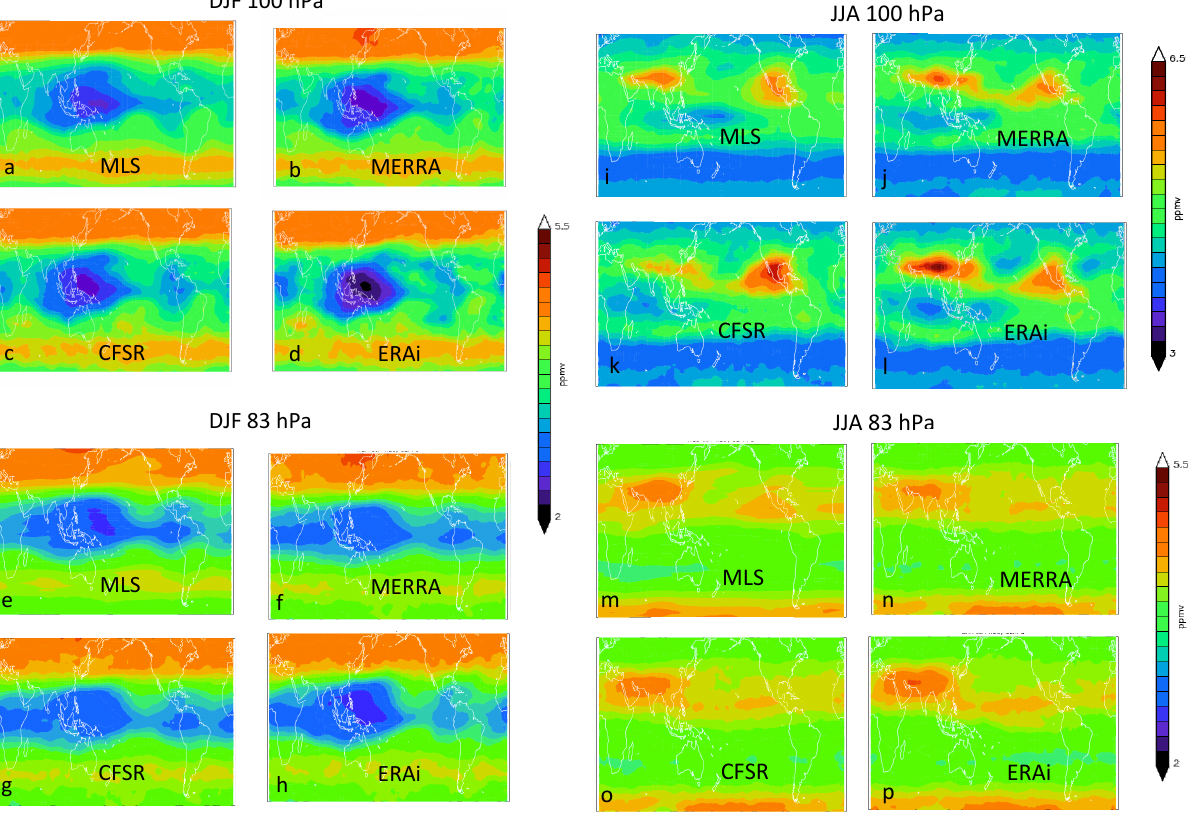
Fig. 2. Water vapor fields for winter at 100hPa (a–d) and 83hPa (e–h) ; and summer 100hPa (i–l) and 83hPa (m–p) . The plots show 2005– 2010 five year averages of MLS and the models using the reanalyses indicated in each of the panels. The zonal mean water vapor fields are normalized to the zonal mean MLS field shown in the upper left of each quad-plot by multiplying by the zonal mean water vapor ratios at each